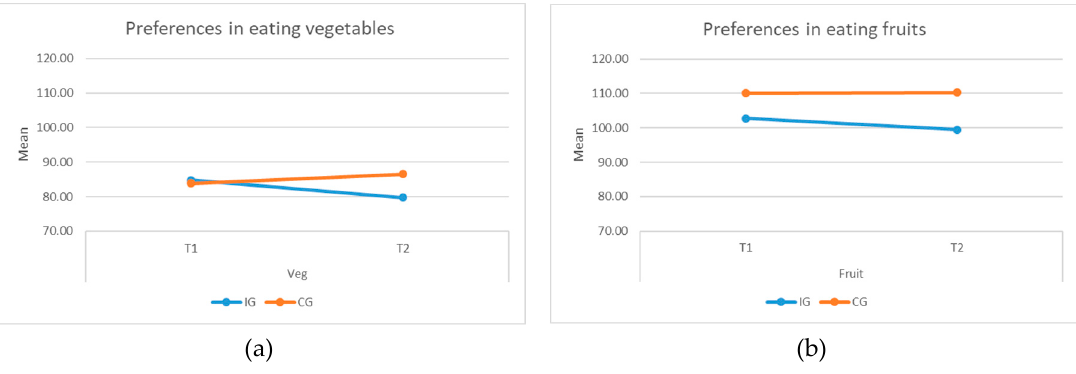
Figure 8. Attitude to eating (a) vegetables and (b) fruits.